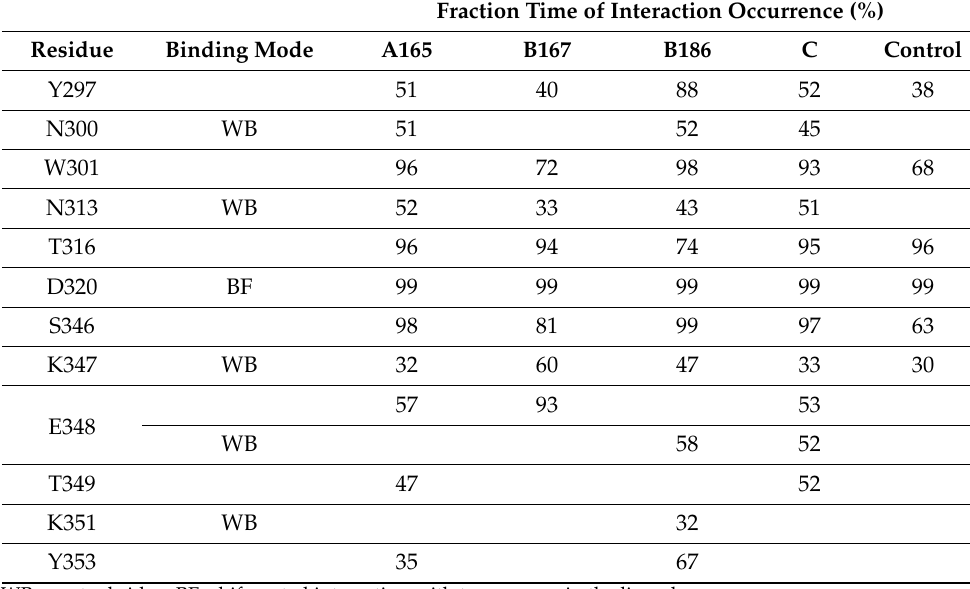
Table 4. Interaction of peptides with NRP1 deconvoluted as fraction time of contact occurrence per protein residue during 30 ns production